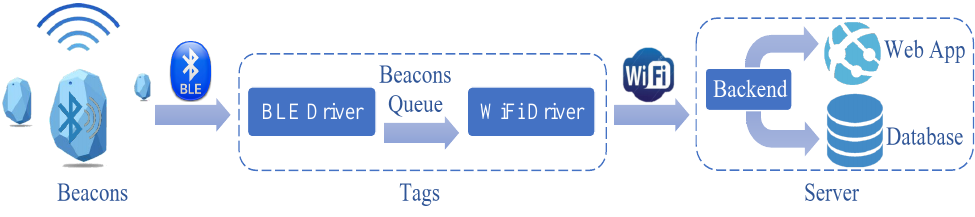
Figure 2. BLE contact tracing IoT system architecture